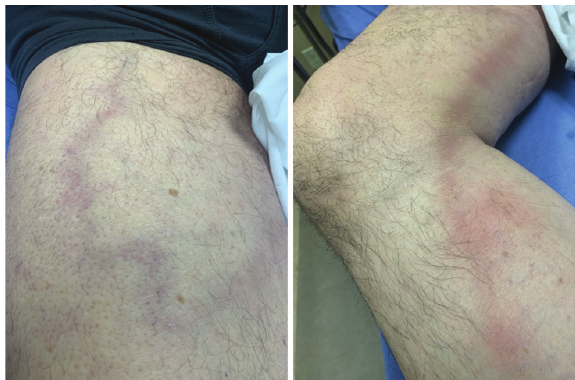
Fig. 1 Picture of the patient ’ s leg showing the outline of the painful vein.